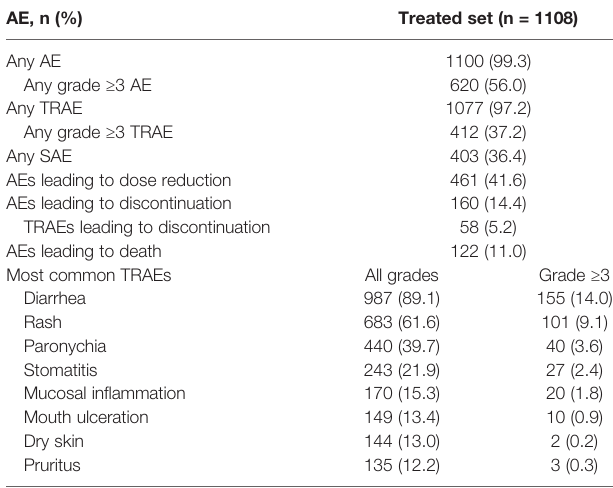
TABLE 2 | Overall summary of AEs, and most common TRAEs (occurring in ≥ 10% of patients). AE, n (%)